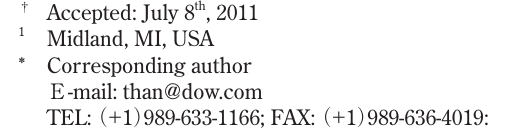
Fig. 1 Jenike-Schulze Wall Friction Cell